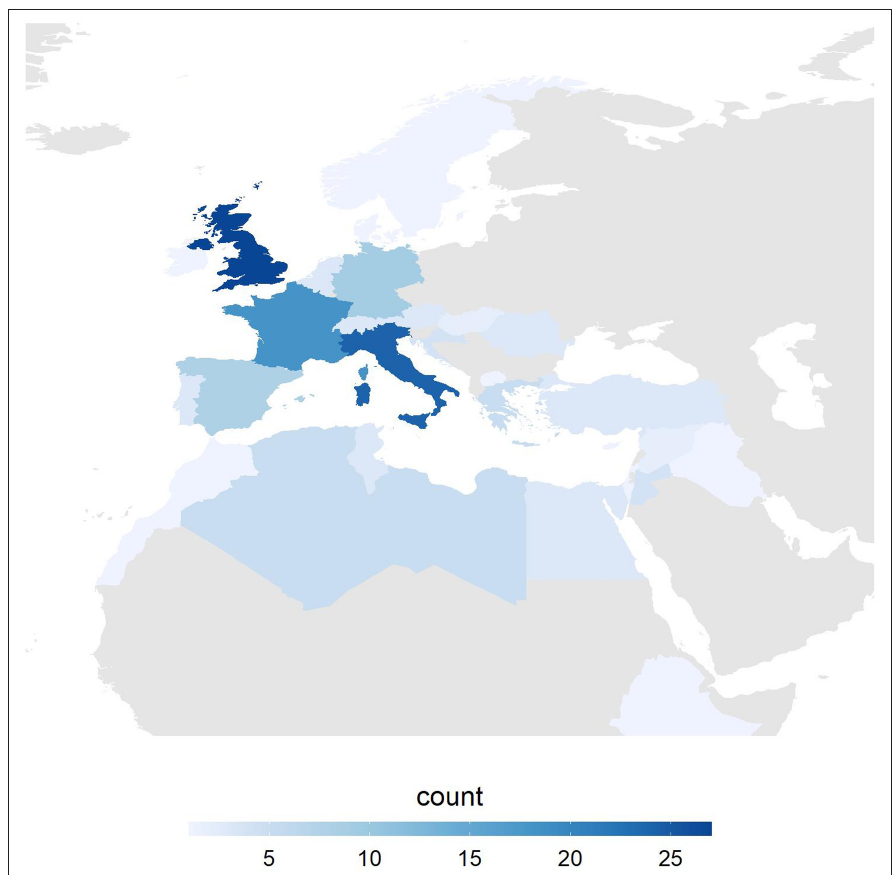
Figure 10: Density map article case study location.